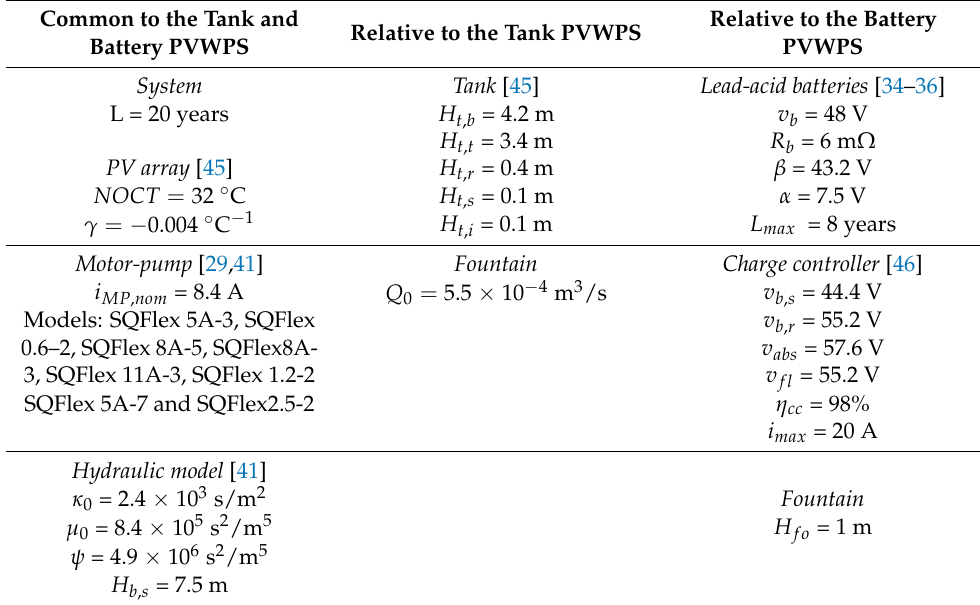
Relative to the Battery